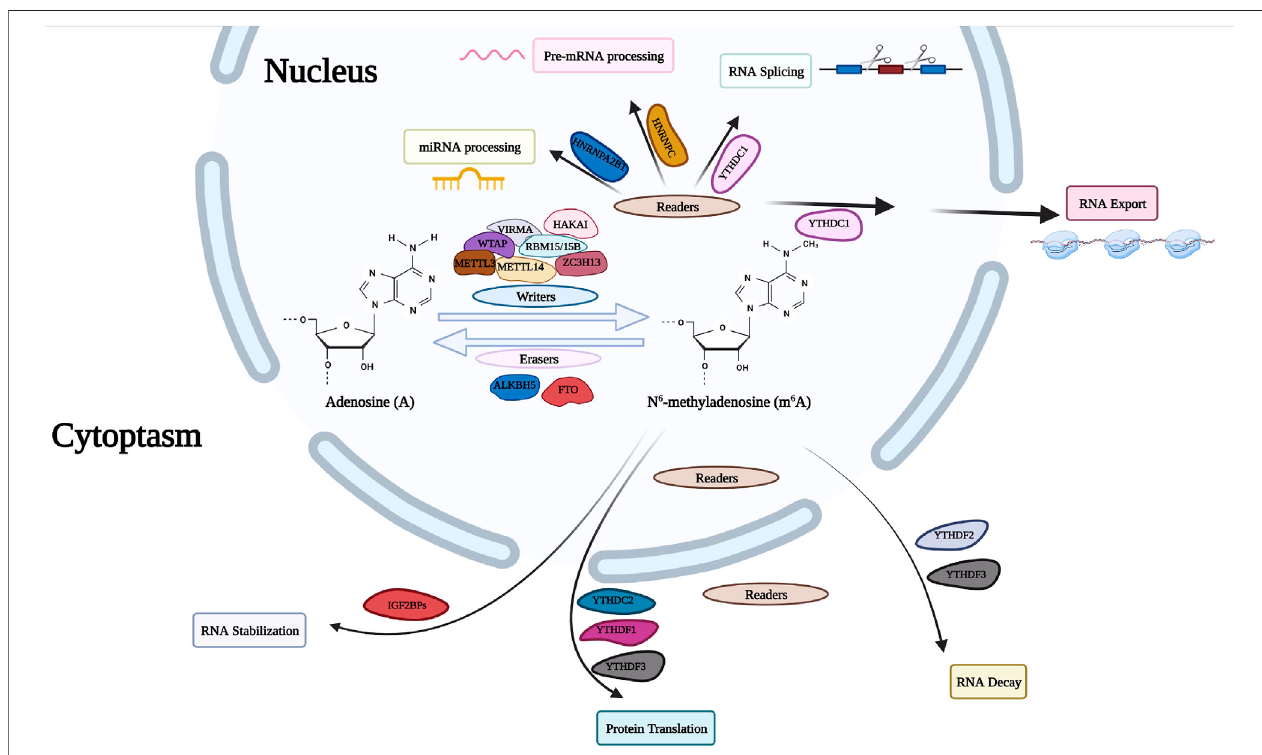
FIGURE 3 | m 6 A RNA modifying process. The RNA modi fi cation of m 6 A is performed by the writer proteins with a polymer complex containing WTAP, HAKAI, METTL3, METTL14, ZC3H13, RBM15, and VIRMA, while the modi fi cation can be removed by the eraser proteins (FTO and ALKBH5). The modi fi cation is identi fi ed by reader proteins including YT521B homology (YTH) domain-containing protein family, HNRNP family and IGF2BPs. WTAP, Wilms Tumor 1 Associated Protein; HAKAI, Cbl Proto-Oncogene Like 1; METTL3, methyltransferase Like 3; METTL14, methyltransferase Like 14; ZC3H13, Zinc Finger CCCH-Type Containing 13; RBM15, RNABinding MotifProtein15;VIRMA,VirLikem 6 Amethyltransferase Associated;FTO, FatMassAndObesity-AssociatedProtein;ALKBH5,AlkBHomolog5;HNRNP, Heterogeneous Nuclear Ribonucleoprotein; IGF2BP, Insulin Like Growth Factor 2 MRNA Binding Protein.